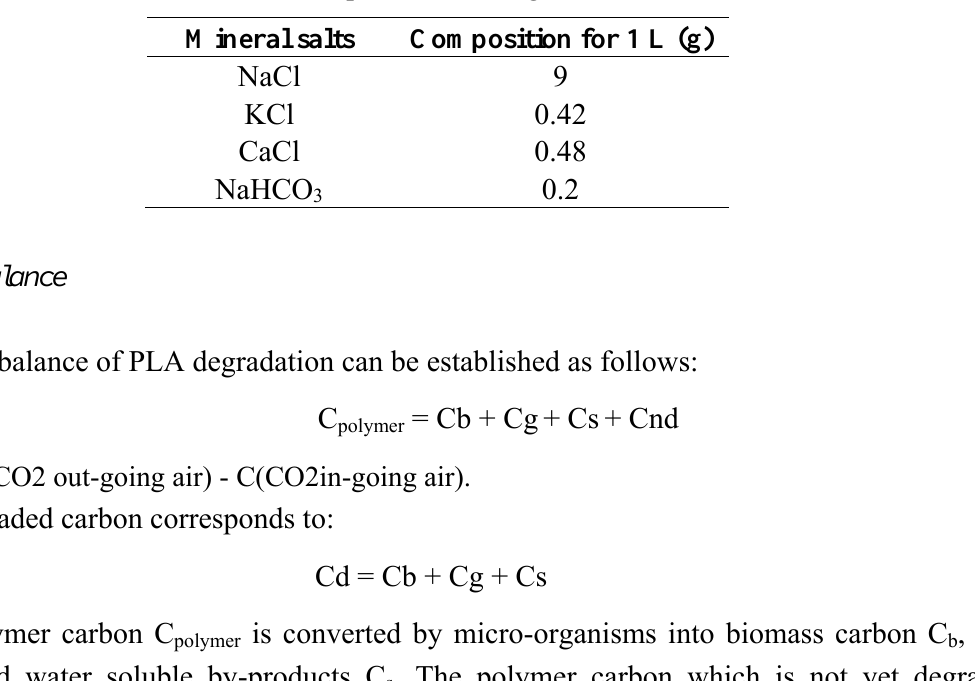
Table 4. Composition of Ringer’s